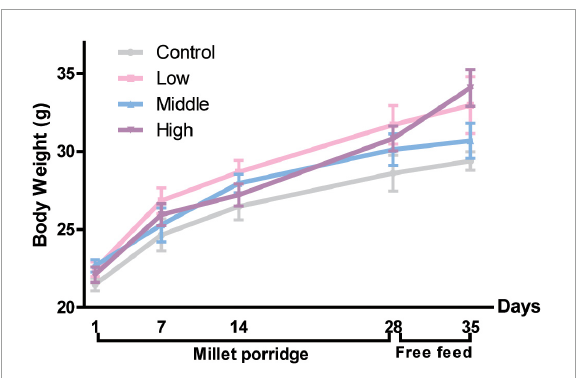
FIGURE1 Body weight of mice. The data are means ± SD. Male Kunming mice were gavaged with millet porridge (3, 6, 12 g/kg body weight each day in the low-, middle-, and high-dose group, respectively) for 28 days, then free-fed for another 7